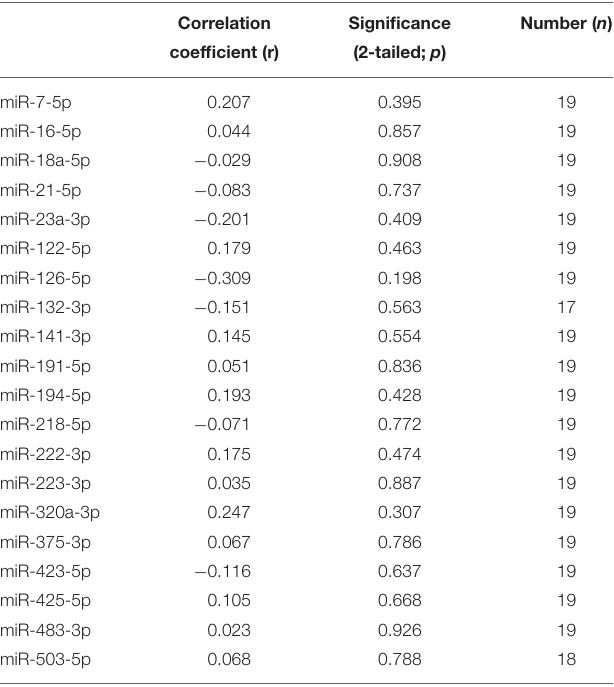
TABLE 1 | Correlation of pre-operative circulating miRNA expression with pituitary height to brain area value in dogs with PDH. Correlation Significance Number ( n ) coefficient (r) (2-tailed; p